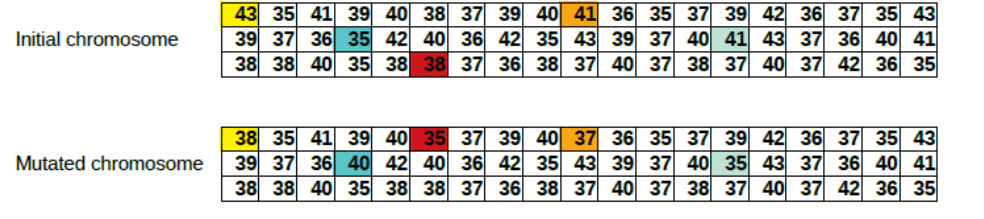
Figure 8. Mutation operation for power